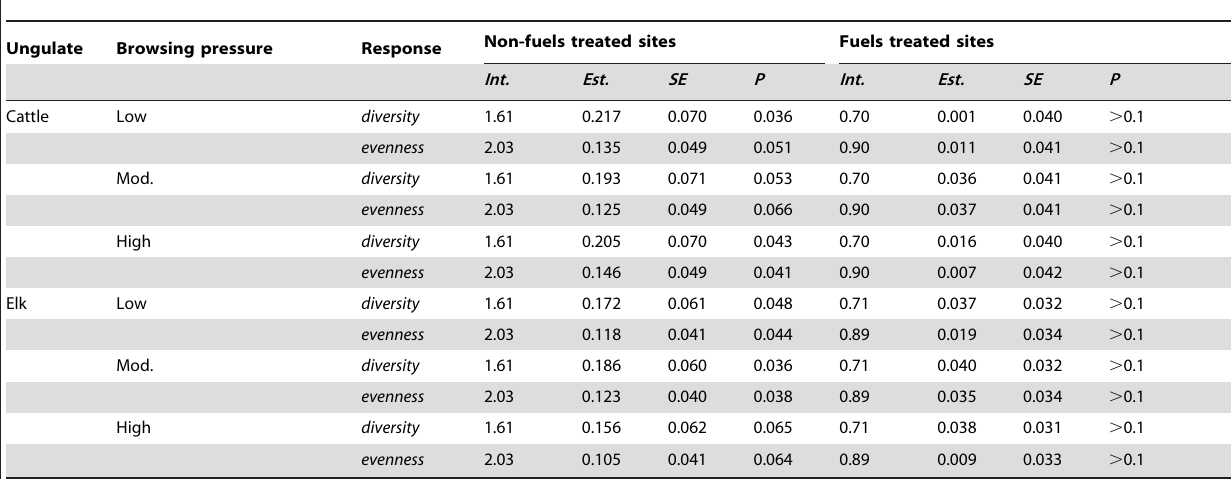
Table 2. Mixed model results showing effect of ungulate browsing on shrub species diversity and evenness at non-fuels treated and fuels treated